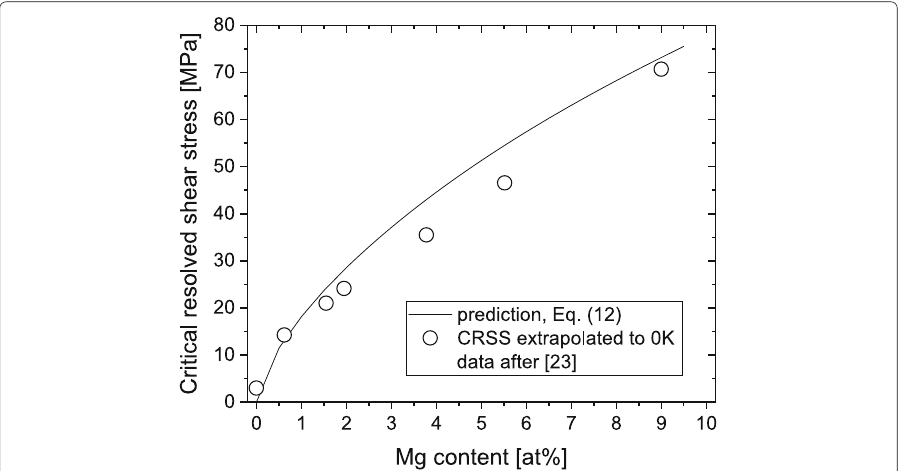
Fig. 6 Extrapolated zero-temperature CRSS data obtained from measurements of Podkuyko and Pustovalov (Podkuyko and Pustovalov 1978) on AlMg x single crystals, and prediction derived from Eq.